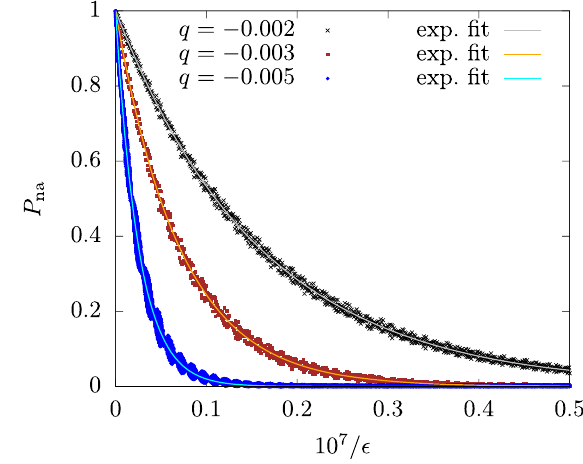
FIG. 4. Evolution of P as a function of 1 = ϵ for an exponential na distribution of initial conditions and different values of q . Exponential fits are also presented. The map (60) has been used, 2 . 602 , ω 2 . 5 , ω 2 . 7 , and a set with parameters ω x ¼ y ; i ¼ y ; f ¼